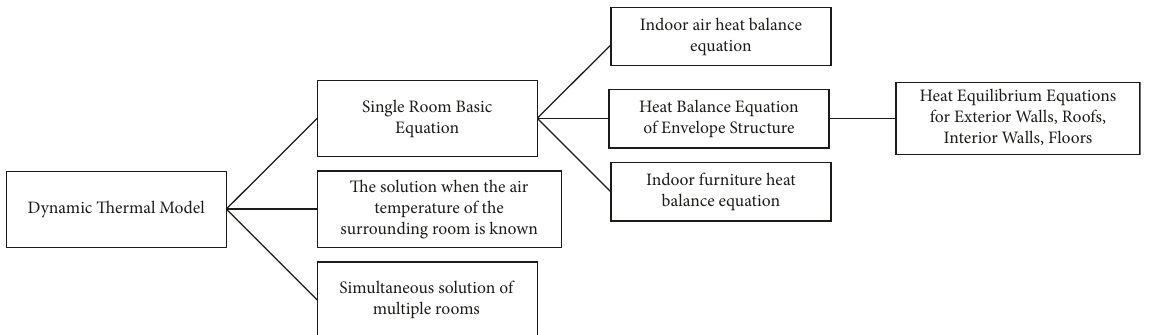
Figure 7: Dynamic thermal model